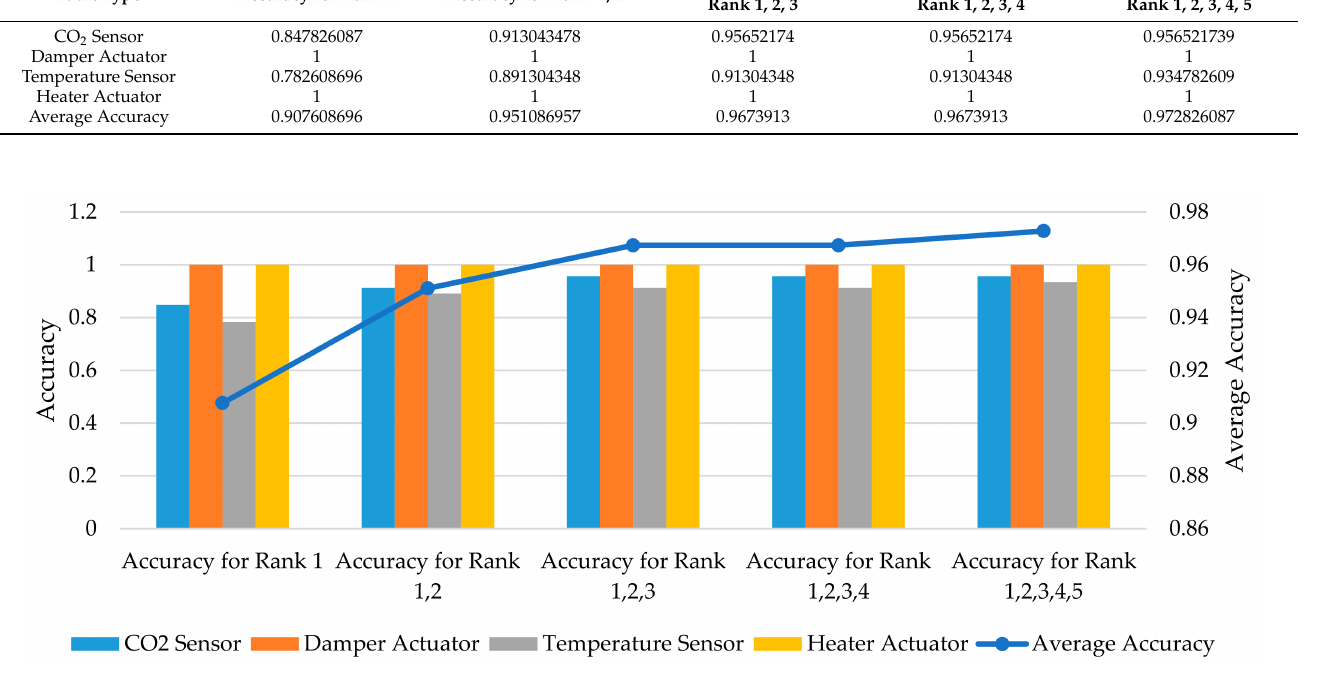
Figure 20. Accuracy and average accuracy in different ranks for different fault types.